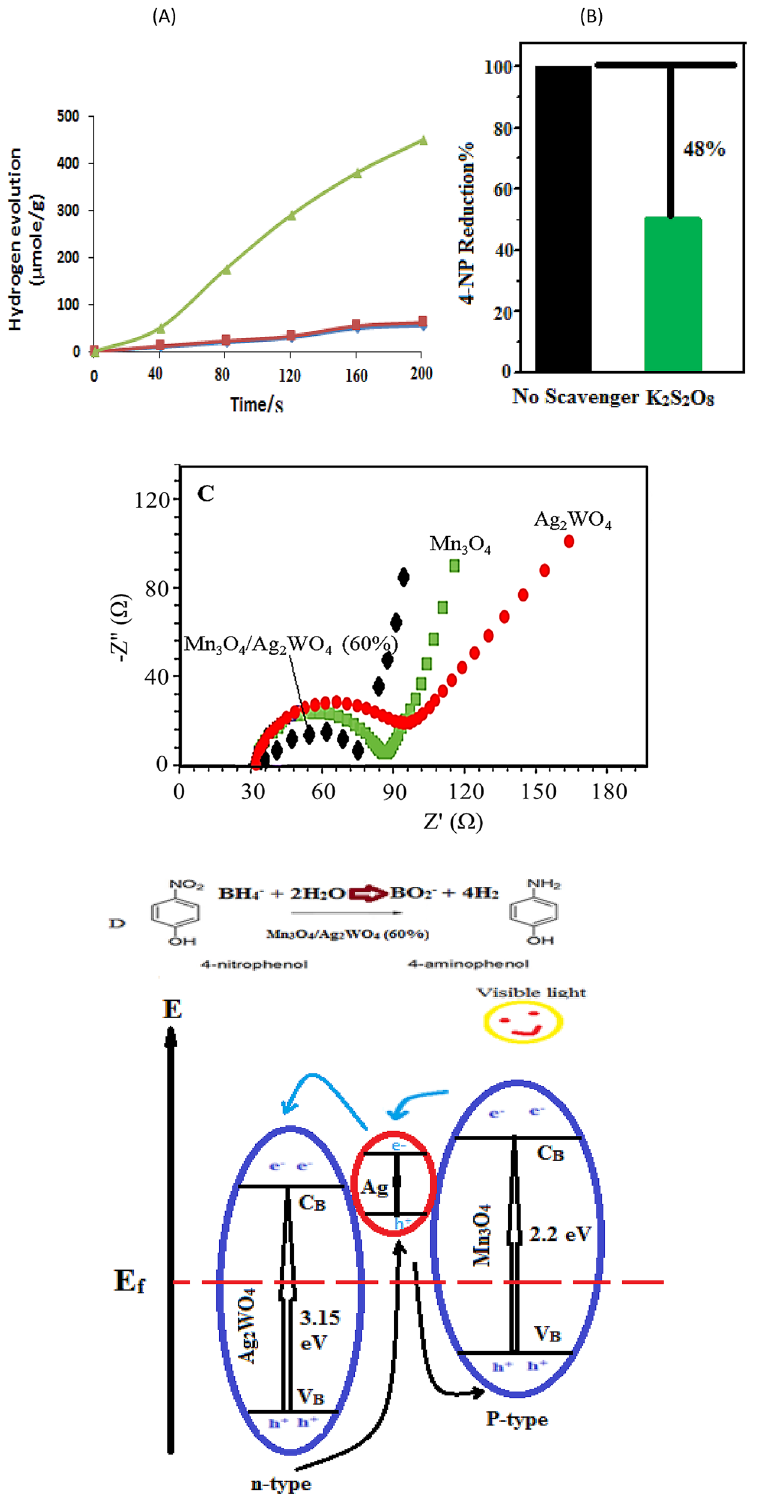
Figure 12. ( A ) Volume of H 2 produced vs. time, from the borohydride reaction promoted by the different photocatalysts (1.0 g), ( B ) Effect of the K 2 S 2 O 8 scavenger on the reduction consequences of 4-NP during the photoreduction process using Mn 3 O 4 /α-Ag 2 WO 4 (60%). ( C ) EIS curves of the photocatalysts performed in 6.0 M KOH and ( D ) Schematic diagram for the reduction mechanism of 4-NP via electron transfer and hydrogen using the photocatalyst Mn 3 O 4 /α-Ag 2 WO 4